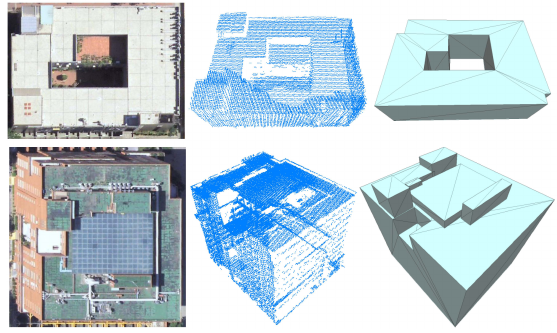
Figure 11. Tested building models. ( Left ): orthogonal image; ( Middle ): airborne LiDAR point clouds; ( Right ): 3D models downloaded from the Internet.